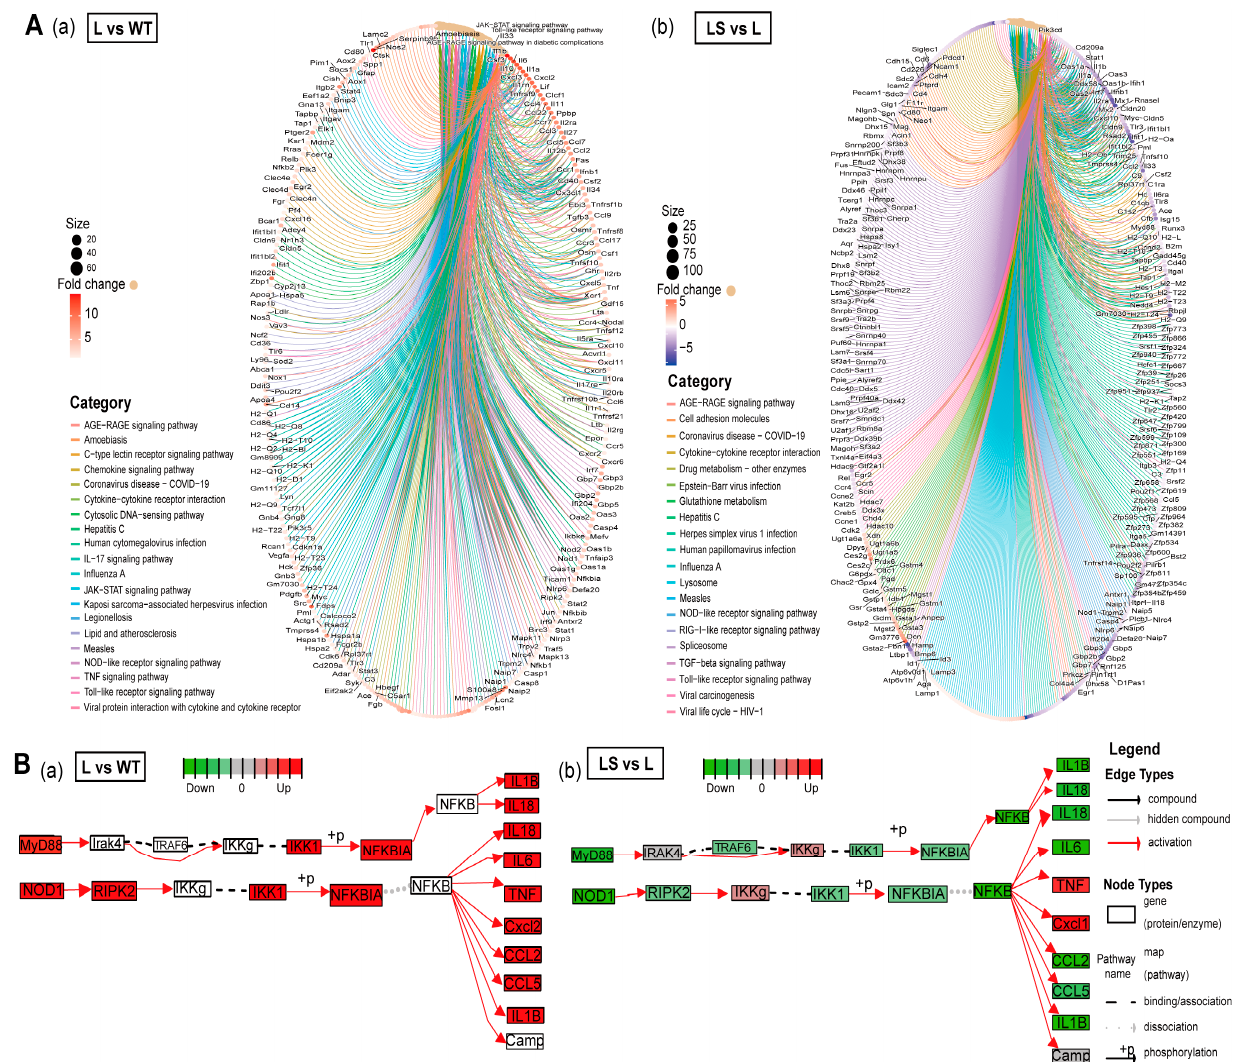
Figure 6. The anti-inflammatory mechanism of sericin SS2. ( A ) Gene regulation in the top 20 different pathways. The fold change decreases from red to purple. ( a ) L/WT. ( b ) LS/L. ( B ) The flow chart of differential gene expression level in MyD88/NF- κ B pathway among different samples. ( a ) L/WT. ( b ) LS/L. Green represents down-regulation and red represents up-regulation.